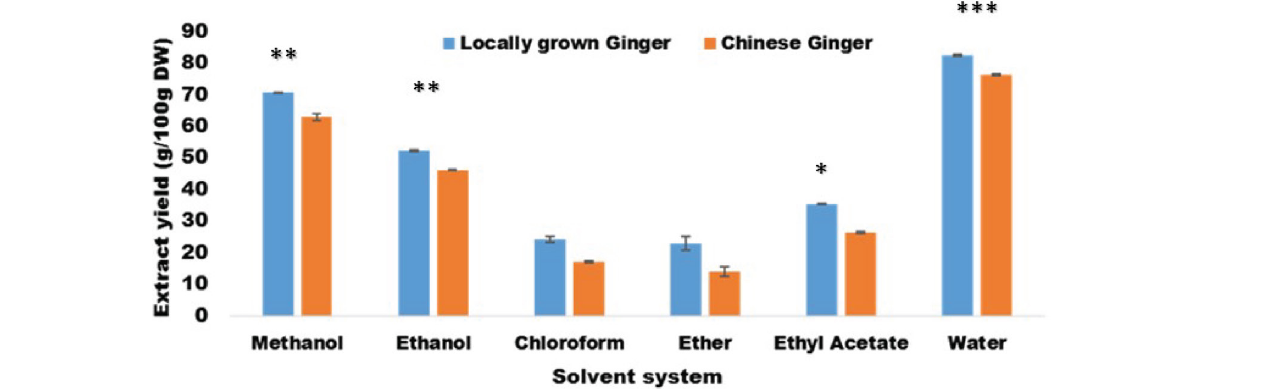
FIGURE 2 - Extraction yields (g/100g) of bioactive extracts from two varieties of ginger ( Zingiber officinale ) with different solvents. All values were taken in triplicate ( n = 3 ). There was significant difference observed in all solvent’s extraction having p < 0.05. The *, **, *** indicates the level of significance (< 0.05 or < 0.01 or < 0.001) among extraction